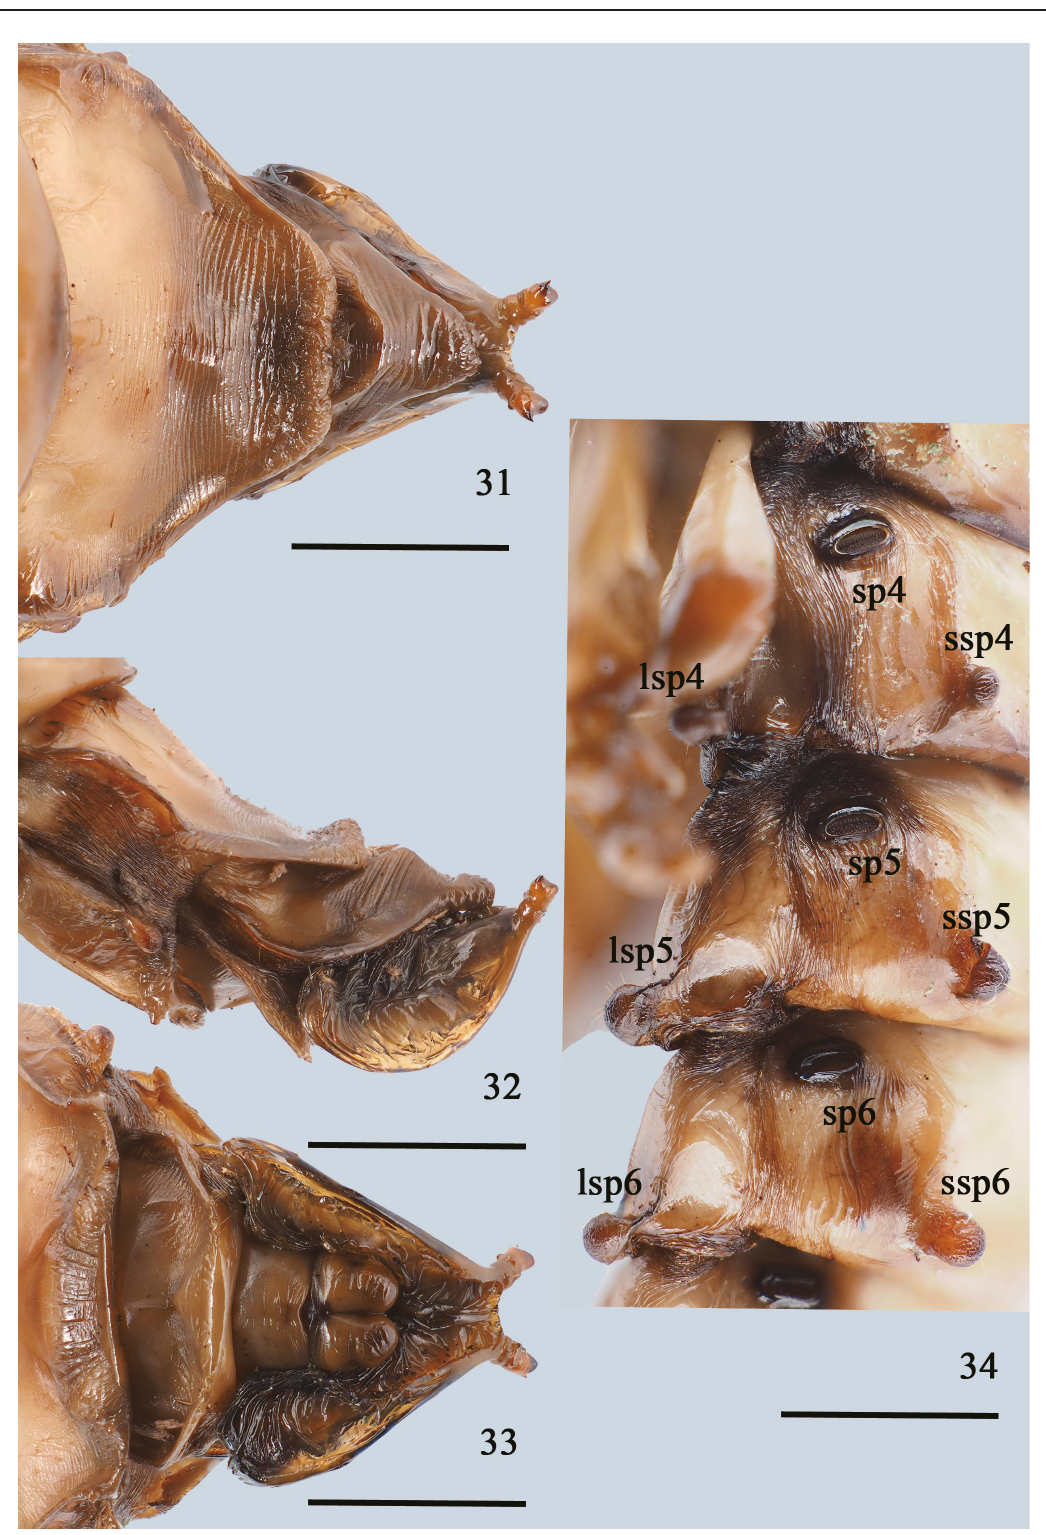
Figs 31–34. Abdominal segment 9, spherical protrusions and spiracles of pupa of Trictenotoma formosana Kriesche, 1919. 31–33 . Abdominal segment 9 (31 = dorsal view, 32 = lateral view, 33 = ventral view). 34 . Spherical protrusions and spiracles on segments 4–6, lateral view. Abbreviations: sp = spiracle; lsp = lateral spherical protrusion; ssp = second spherical protrusion. Scale bars: 31–33 = 3 mm; 34 =